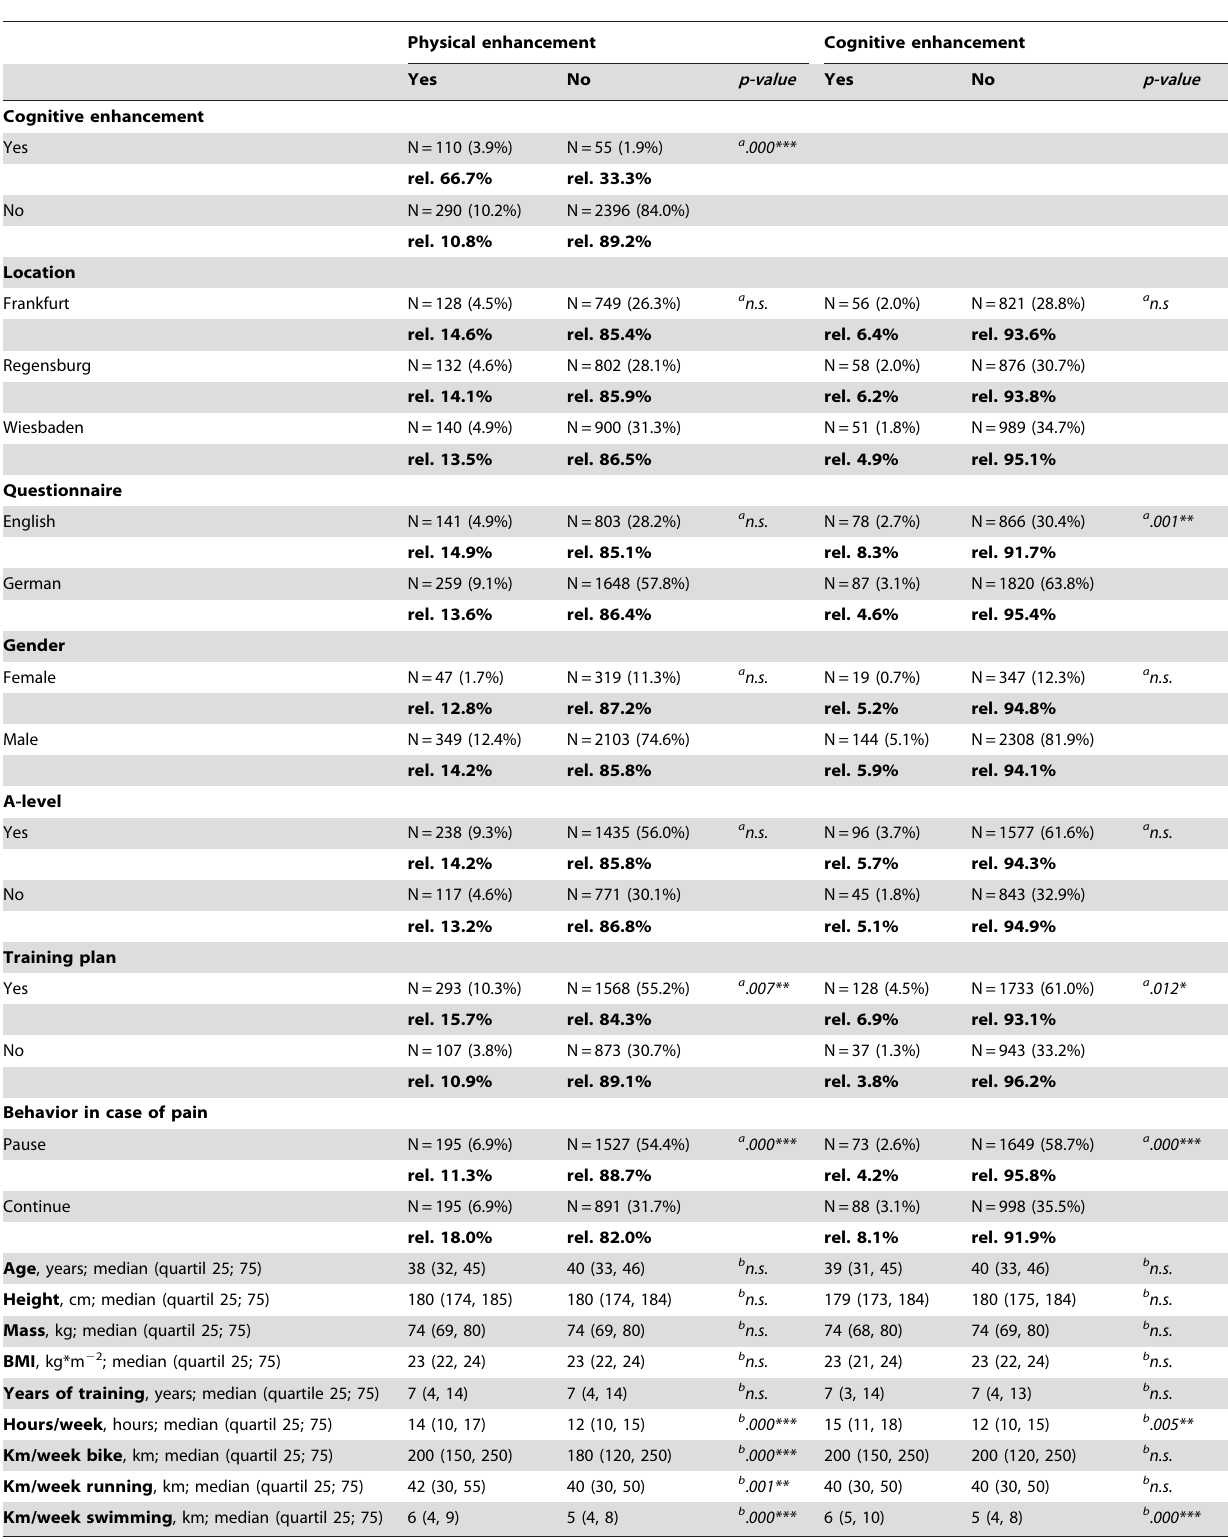
Table 7. Associations between the two dependent variables ‘physical enhancement’ and ‘cognitive enhancement’ and each predictor